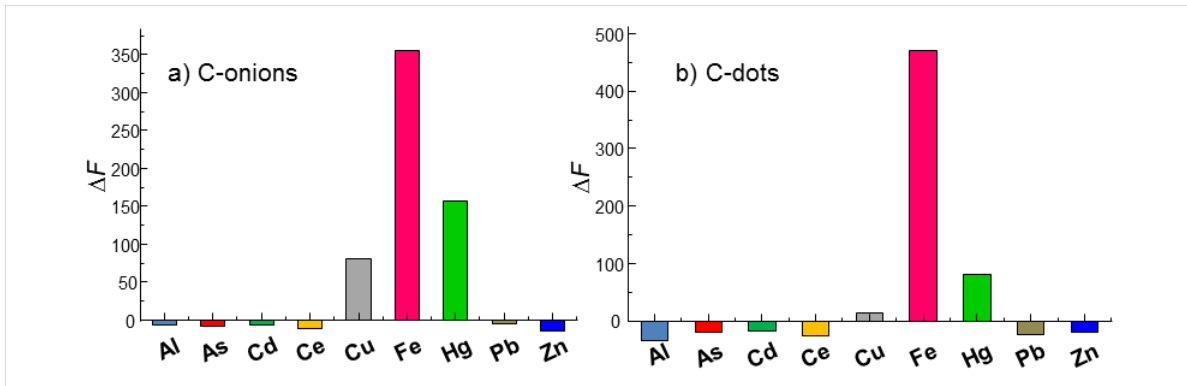
Figure 6: Effect of some metals on the photoluminescence spectra of C-NPs at pH 6. a) C-onions measured at λ ex = 328 nm. Slit width of emission and excitation was 10 and 20, respectively. b) C-dots measured at λ ex = 362 nm. The slit widths of emission and excitation were both 20 nm. The con- centration of metals was 10 ppm in all